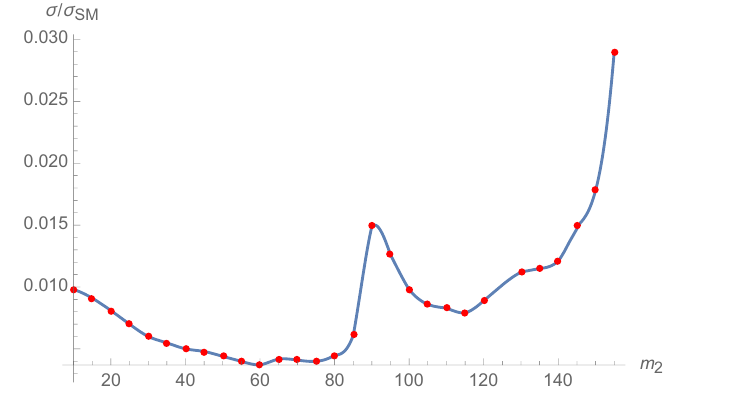
Figure 8 . The 95% CL exclusion limits [18, 50, 51] on the cross section for (cid:27) ( e + e (cid:0) ! Z + (cid:1) (cid:1) (cid:1) ) =(cid:27) SM p at the ILC at s = 250 GeV as a function of the mass of the extra Higgs boson h 2 . The ellipsis denotes an undetected (cid:12)nal state of invariant mass m 2 . The SM cross section assumes m h Limits calculated using the CL(s) approach